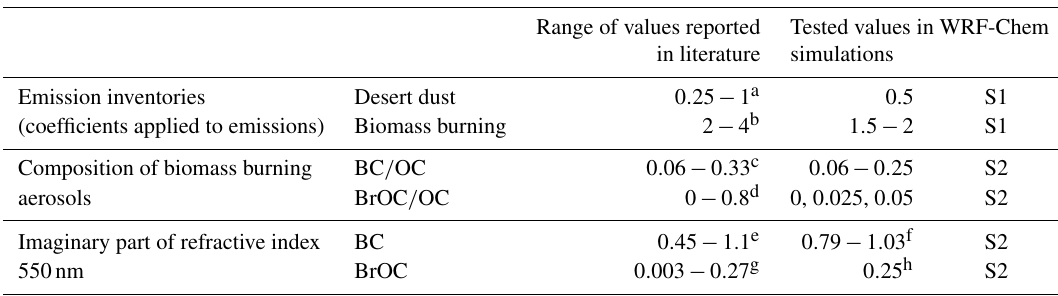
Table 2. Main parameters investigated, with range of values tested in simulations experiments performed with WRF-Chem, considering the range of values reported in the literature. As indicated in Fig. 3, S1 corresponds to the WRF-Chem partially constrained simulation and S2 to the WRF-Chem optimized configuration. BC, OC and BrOC represent the black carbon, organic carbon and brown carbon in biomass burning aerosols emitted by